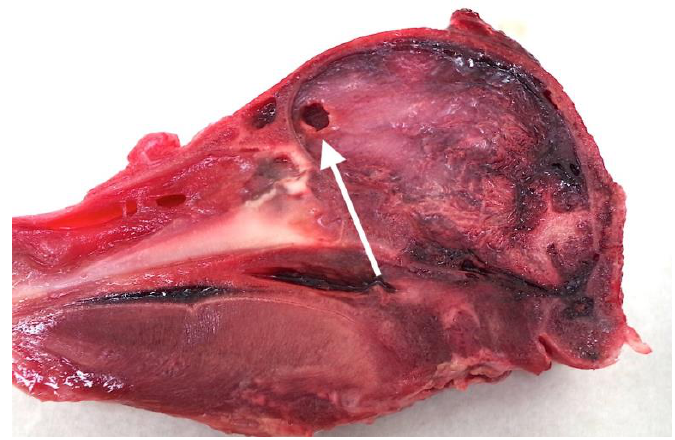
Figure 12. Arrow pointing to a neopallial cyst (pronecephaly) within the frontal cerebrum of Kid 161.